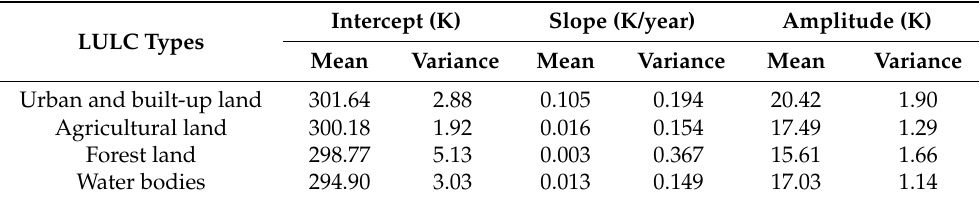
Impact of LULC change on harmonic terms of LST Table 10 lists the mean values of LST harmonic terms from the pixels and demonstrates that their LULC type changed from agricultural land, forest land, and water bodies to urban and built-up land during 2001 and 2020. Table 10. Thermal signatures and thermal signature changes of the LULC change type. Change Types